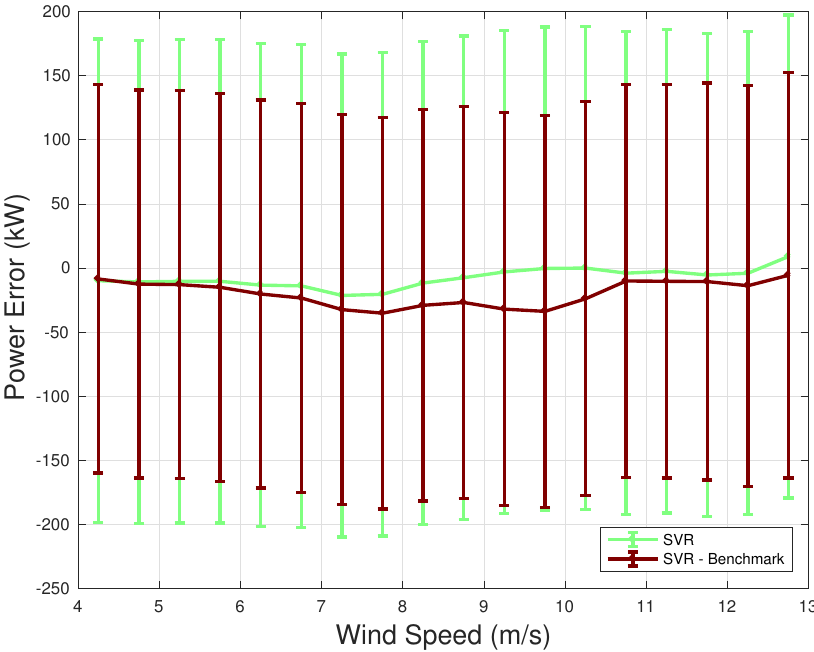
Figure 5. Average error between model predictions and model estimate: SVR and SVR benchmark.